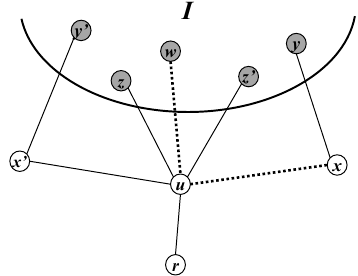
Figure 1. An iteration of Algorithm 1. After edge ( u , w ) is included in tree T , the D-GENfunction randomly picks ( x , u ) from { ( x , u ) , ( x (cid:48) , u ) } and adds it in tree T with probability P d x